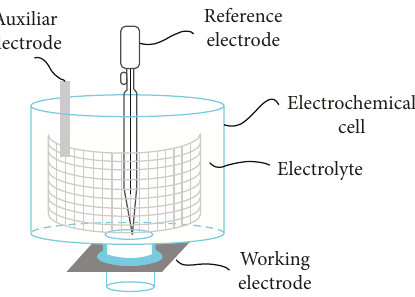
Figure 2: Scheme of experimental setup for obtained thin solid fi lms by the anodization. Figure